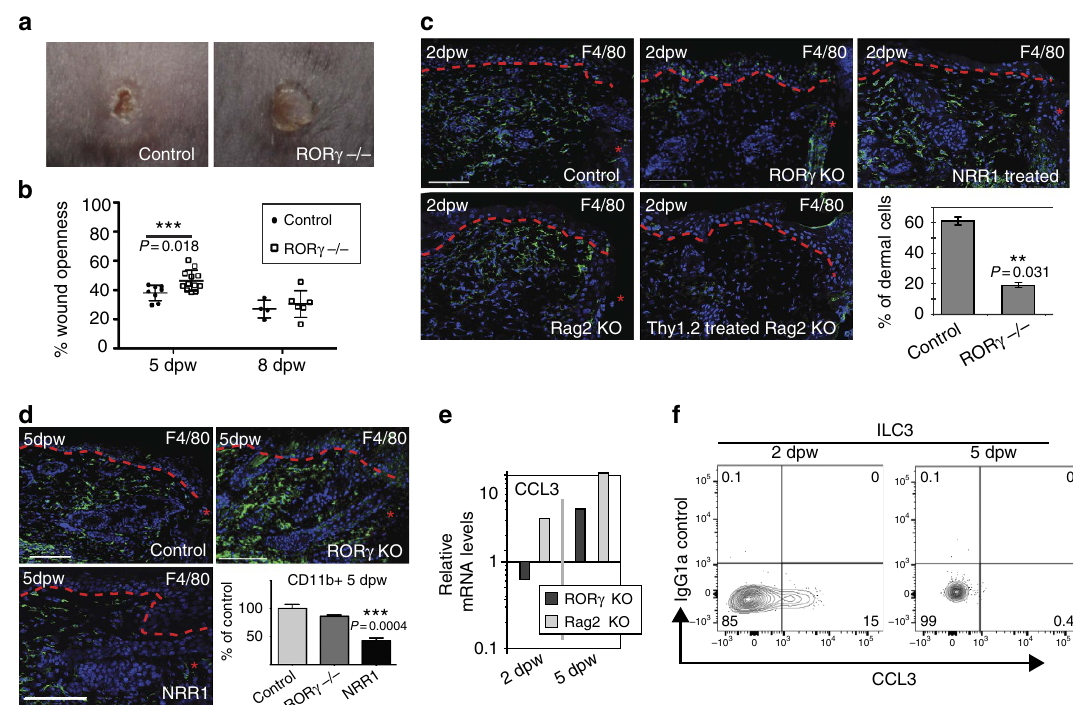
Figure 7 | Notch-recruited ILC3s orchestrate macrophage entry and wound closure through production of CCL3. ( a , b ) 4mm punch-wounded ROR g þ / (cid:3) (control) and ROR g (cid:3) / (cid:3) . ( b ) Quantitative analysis using 3D imaging; wound openness is measured in control and ROR g (cid:3) / (cid:3) wounds at 5 dpw and 8 dpw. The mean openness of ROR g (cid:3) / (cid:3) wounds is significantly greater than that of wildtype mice at 5 dpw ( n ¼ 12 ROR g (cid:3) / (cid:3) ; n ¼ 8 control) but not 8 dpw ( n ¼ 6 ROR g (cid:3) / (cid:3) ; n ¼ 4 control) ( F ¼ 6.721; df ¼ 18; P ¼ 0.018). ( c , d ) Sections of wounded ROR g (cid:3) / (cid:3) (ROR g KO), ROR g þ / (cid:3) /Rag2 (cid:3) / (cid:3) (Rag2 KO), ROR g þ /- /Rag2 (cid:3) / (cid:3) injected with anti-Thy1.2 antibodies (Thy1.2 treated Rag2 KO), wildtype mice treated with NRR1 blocking antibodies (NRR1 treated) and/or wildtype control tissues collected 2 dpw ( c ) or 5 dpw ( d ) stained with antibodies to F4/80 (green) and DAPI counterstained (blue). Graph shows percentage of F4/80 þ dermal cells quantified by cell counting on sections in control verses ROR g (cid:3) / (cid:3) mice 2 dpw. ( d , bottom right panel). Flow cytometry analysis of single cell suspensions from parallel wounding experiments analysed 5 dpw. Cells stained with CD45 and CD11b prior to analysis ( n ¼ 3 for each genotype/time point) and the relative number of CD45 þ CD11b þ cells was determined. Results were normalized (designated 100%) to controls from skin collected 5 dpw. ( e ) mRNA was isolated from unwounded controls ( n ¼ 3) and punch-wounded ROR g (cid:3) / (cid:3) (ROR g KO; n ¼ 3) or Rag2 (cid:3) / (cid:3) (Rag2 KO; n ¼ 3) skin collected 2 dpw or 5 dpw. Relative mRNA levels of CCL3 were quantified by qPCR. mRNA levels were normalized to wildtype skin 2 dpw (designated 1). Data plotted on a log scale; 3 biological replicates. ( f ) CCL3 production in PMA/ionomycin stimulated ILC3s quantitated by flow cytometry 2 and 5 dpw. Red, dashed line ( c , d ) marks epidermal–dermal boundary; single asterisks mark wound site; dpw ¼ days post wounding; graph bars ¼ mean and error bars ¼ standard error of the mean (s.e.m.); scale bars ¼ 100 microns. Results statistically significant as determined by linear mixed effects model ( b ) or Student’s t -test ( c , d ) marked with ** or ***; P -values included on